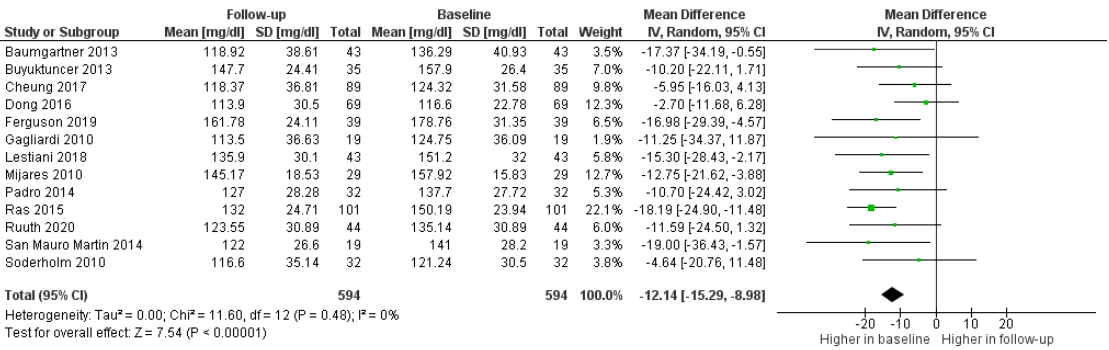
Figure 2. Forest plot comparing baseline and follow up LDL values among treated participants.